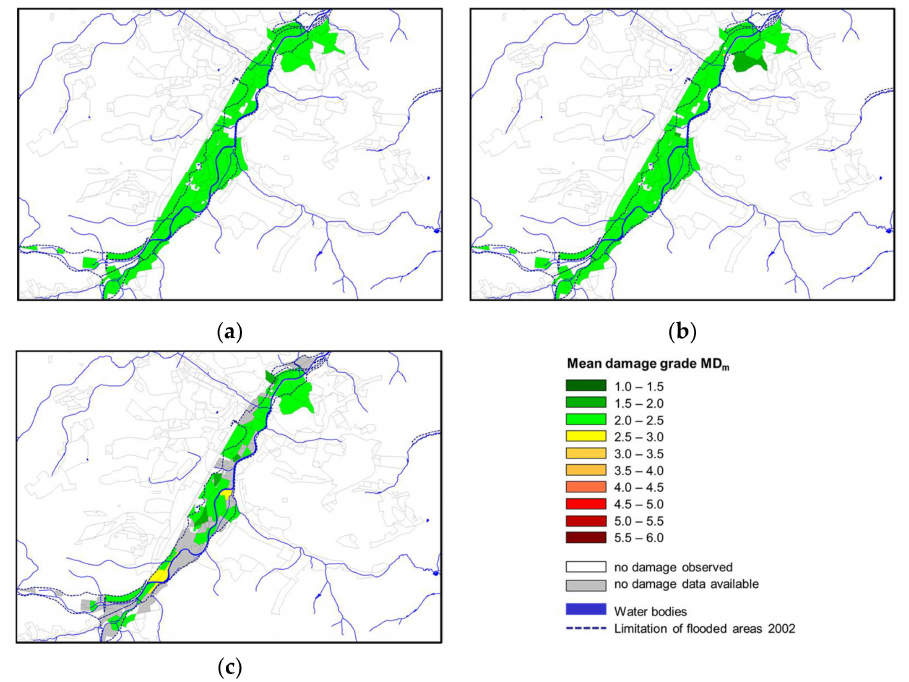
Figure 14. Comparison of the calculated mean damage grades ( MD m,calc ) in the land-use areas and the observed damages ( MD m,obs ) in the Freital investigation area: ( a ) calculated mean damage grades ( MD m,calc ), Level I; ( b ) calculated mean damage grades ( MD m,calc ), Level II; ( c ) observed mean damage grades ( MD m,obs